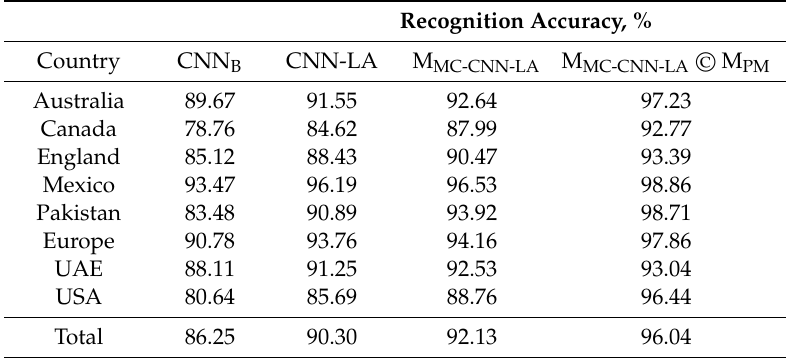
Table 5. Performance comparison of di ff erent modules of proposed recognition